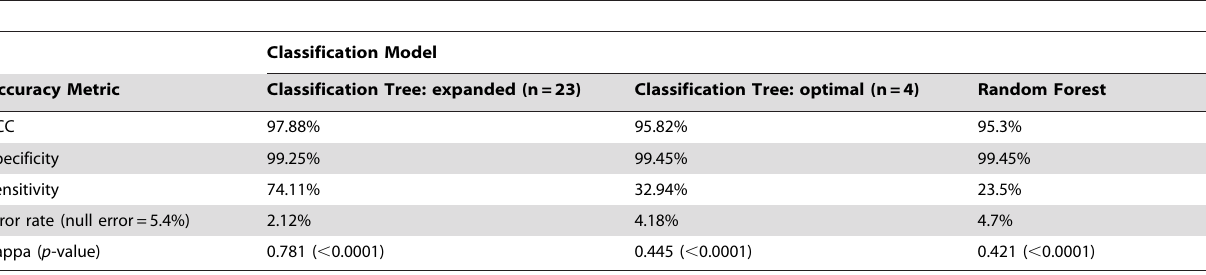
Table 1. Accuracy measures for predictions of threat status in birds species with current geographic range size and external threats (n=1557